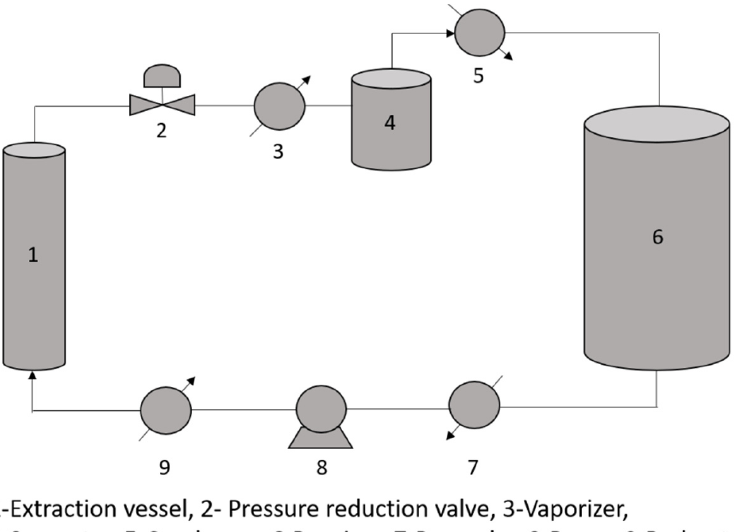
Figure 7. General flow diagram of a supercritical fluid extraction process from solid material [39].